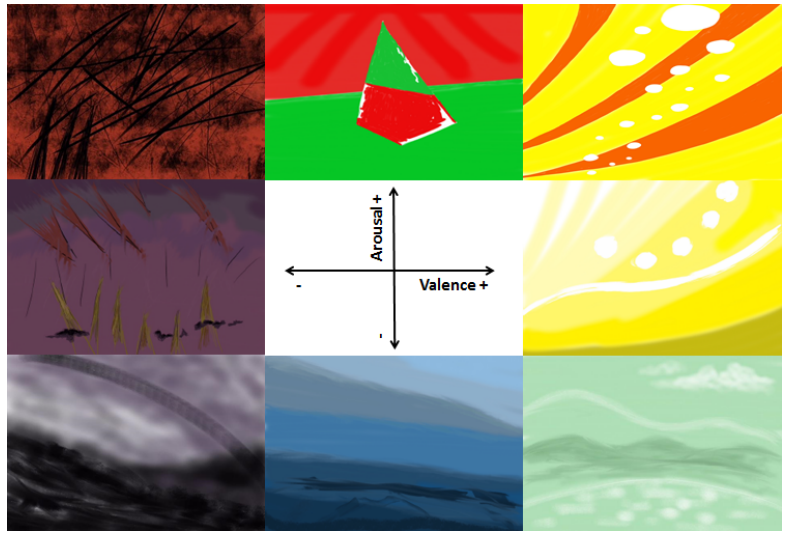
Figure 4. iPad sketches by an artist, illustrating some possibilities for expressing emotions visually. All images c (cid:13) 2017 Dan Koon. Used here with